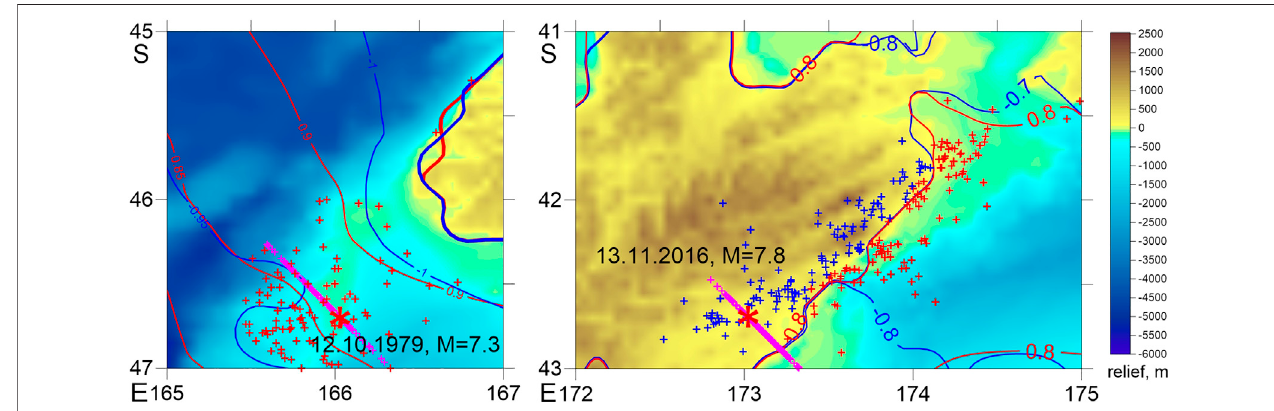
FIGURE1| Mapsoftidalheightsandexamplesofaftershocksequencesintheinterval( t c ,720 h)ofM (cid:1) 7.3earthquakeofOctober12,1979,NewZealand (A) and M (cid:1) 7.8earthquakeofNovember13,2016, New Zealand (B) .Crossesmarkaftershockepicenters:red in theocean, blueon land. Red contours show maximum ocean levels, whereas blue contours show minimum levels. Colour scale shows the relief (m) with respect to sea level.